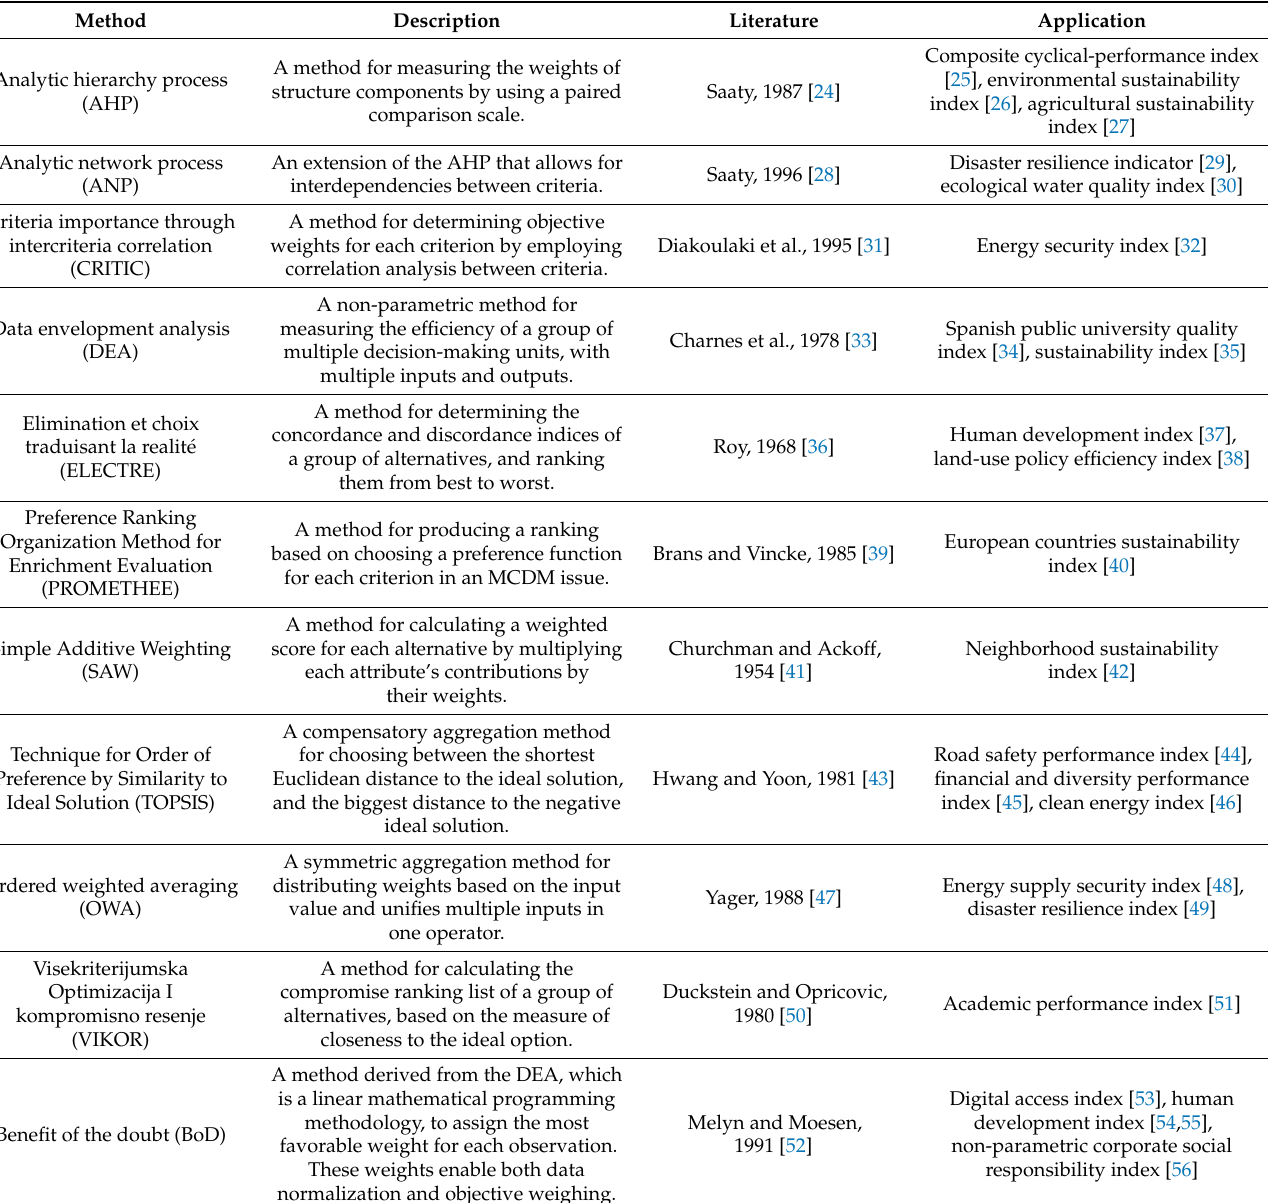
Table 1. MCDM methods for the construction of composite